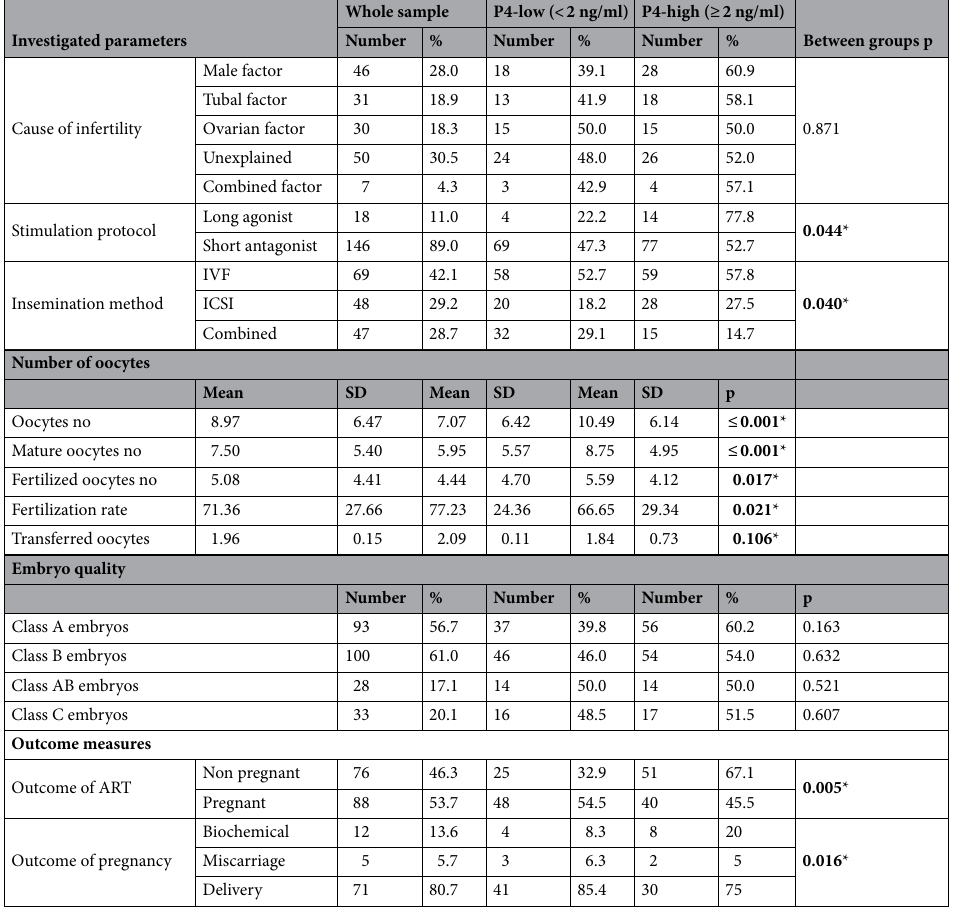
Table 2. Clinical features and procedure outcome depending of P4 level on the day of OR. *p <